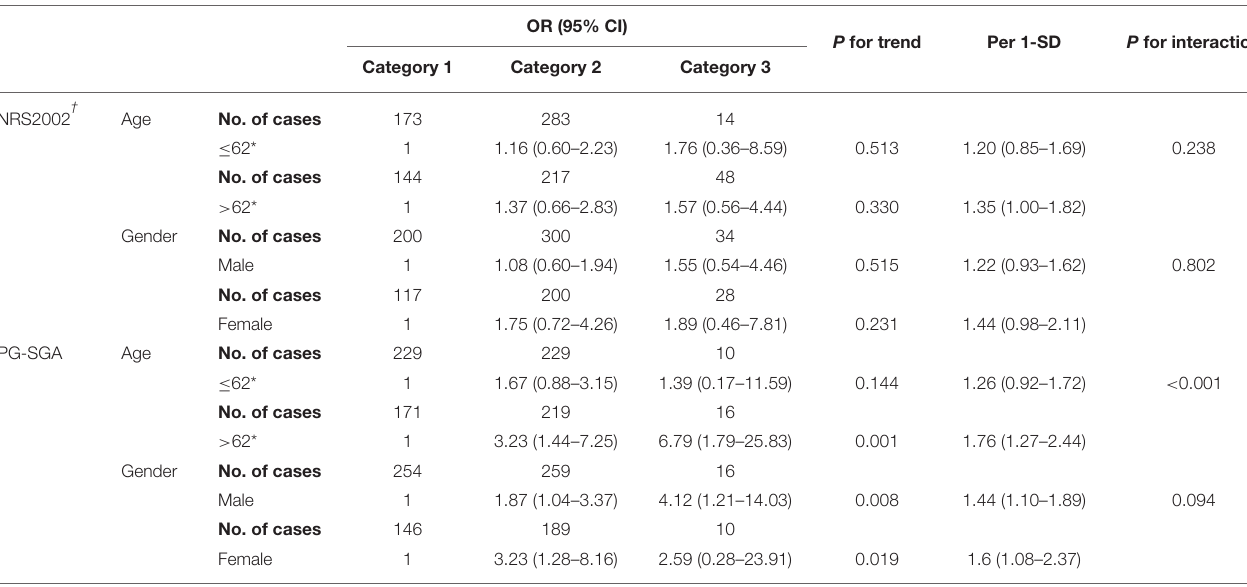
TABLE 4B | Stratified analysis of CRC (age and